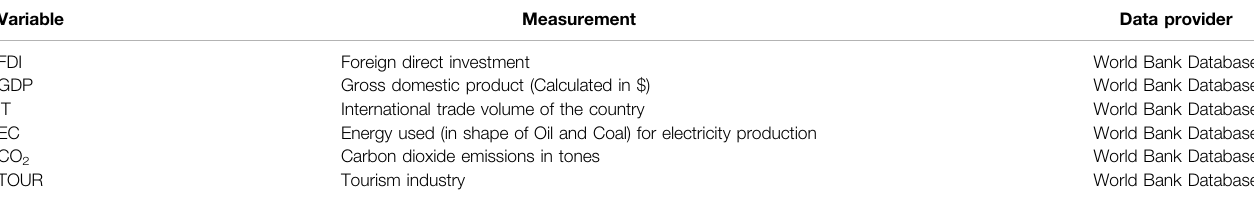
TABLE 1 | Provides the brief information of variables and